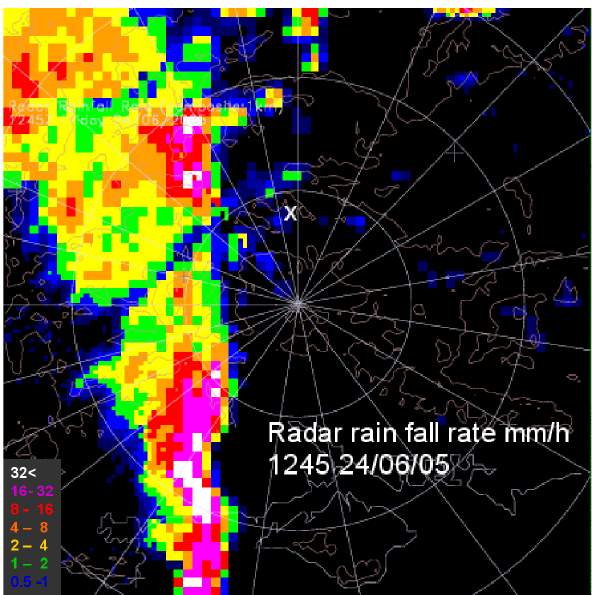
Fig. 5a. Composite weather radar rainfall for the 24 June 2005 at 12:45UTC. The white cross indicate Linkenholt site. The rain rate/h is indicated by the colour scale on the bottom left. The bulls- eye is centred at the Chilbolton radar with the first and second cir- cles of radius 25 and 50km.